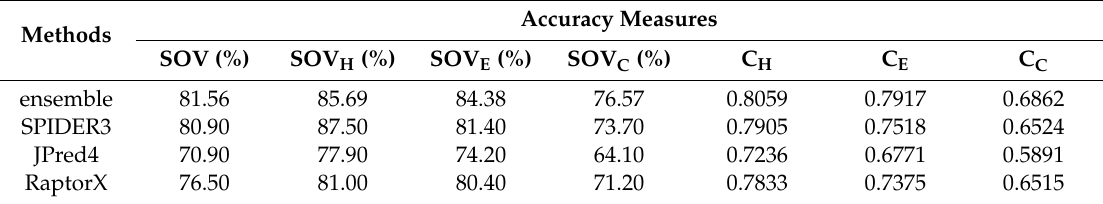
Table 2. SOV scores and MCC results by four di ff erent methods for data1199.